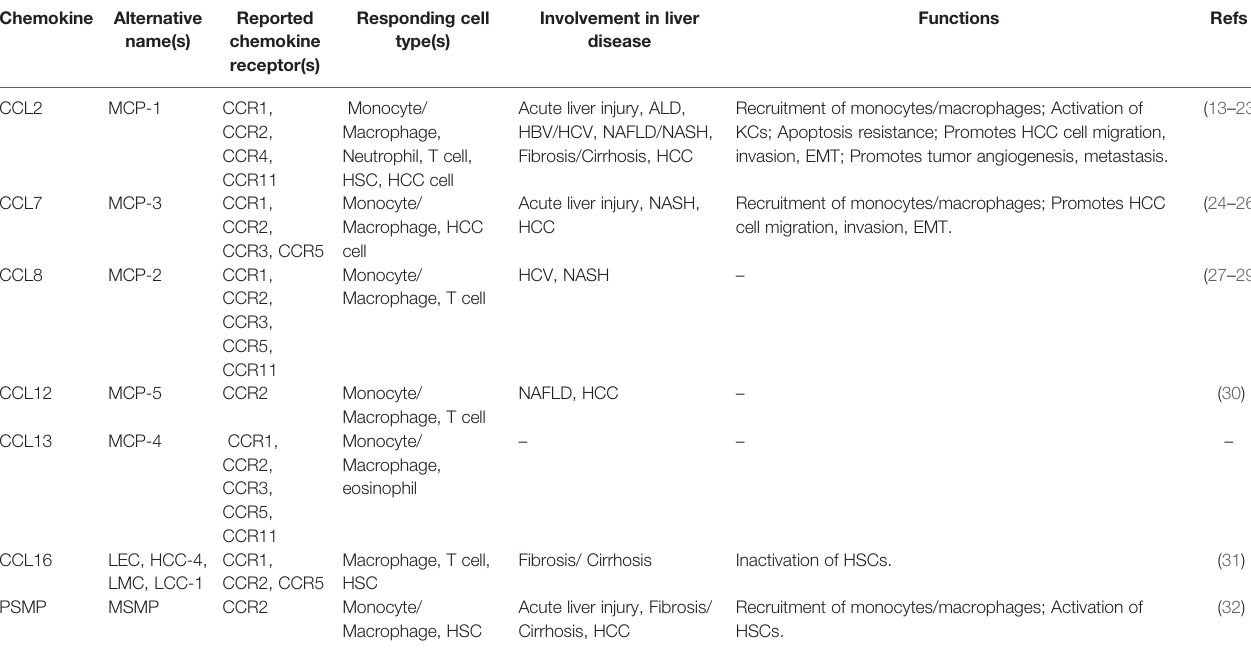
TABLE 1 | Relevant chemokine ligands of CCR2 in the pathogenesis of liver diseases. Chemokine Alternative